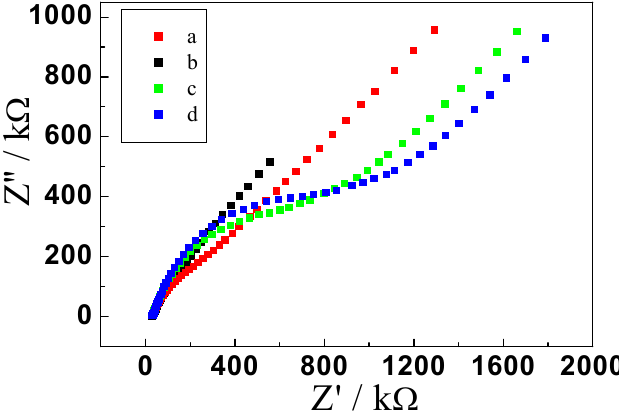
10 mmol/L Fe(CN) 63 − /4 − containing 0.1 mol/L KCl, and the frequency range used was 0.1 to 1 × 10 5